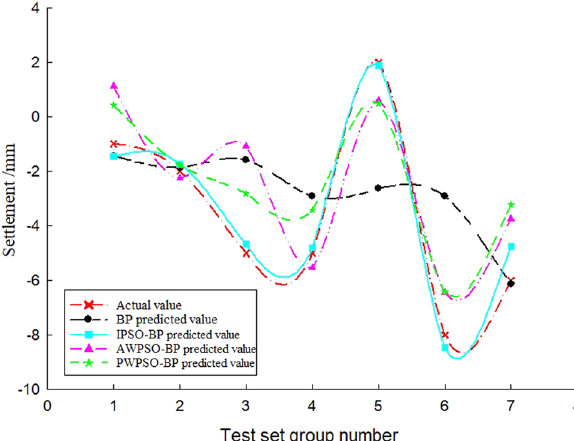
Figure 12. Left Z-3 measuring point.